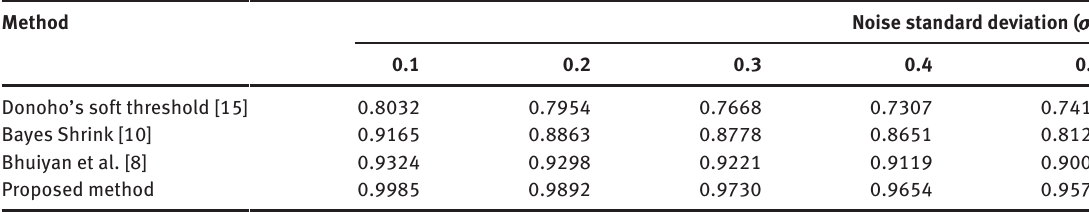
Table 3: Comparison of Pratt-FOM Performance for MR Images.